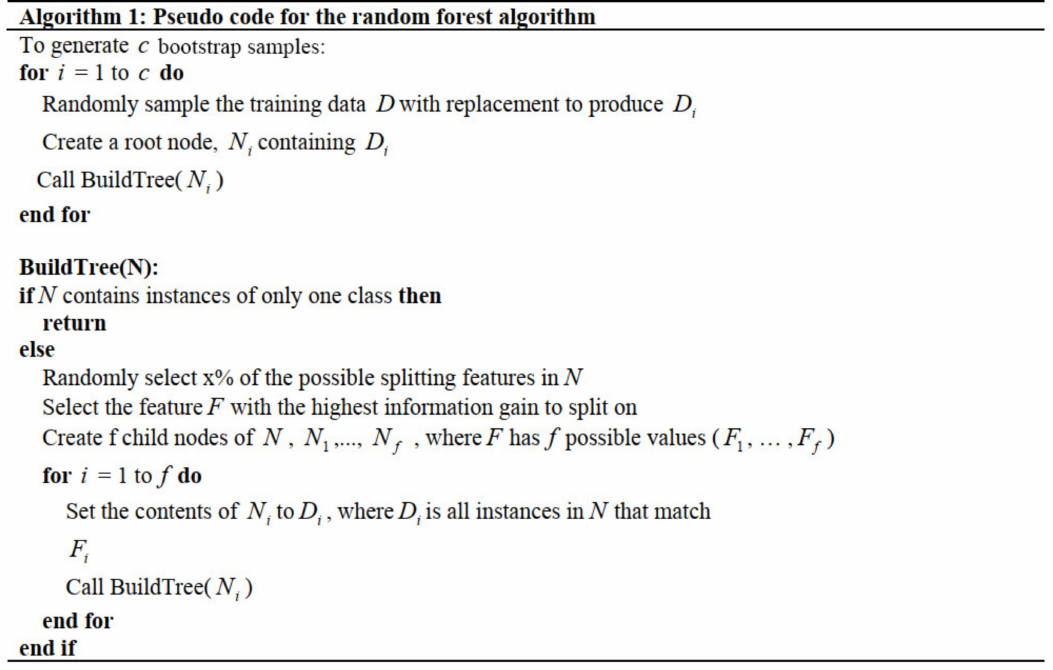
Figure 3. The pseudo-code of the RF